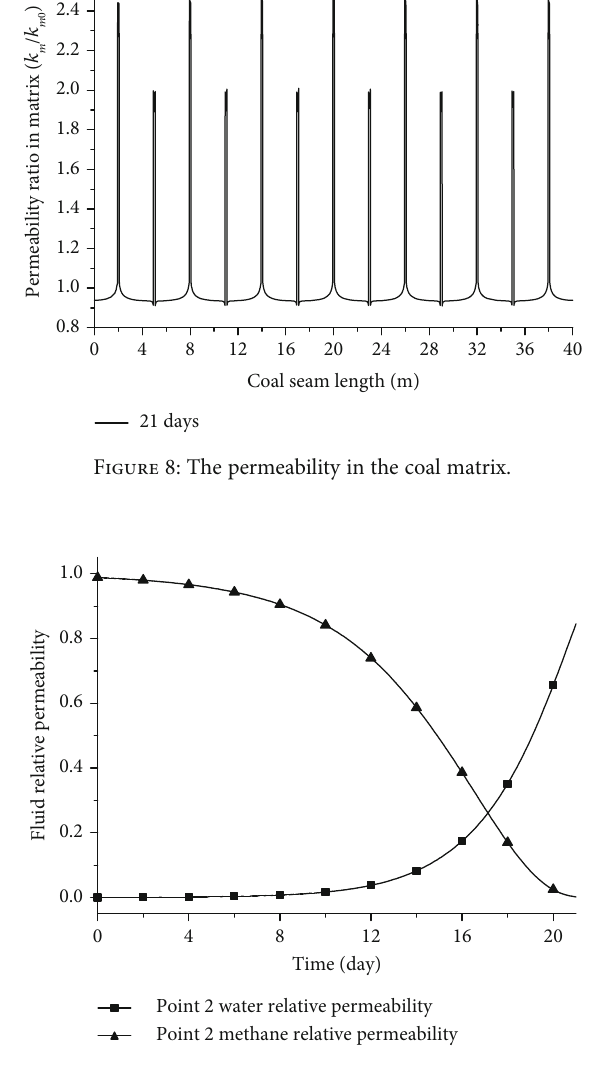
Figure 9: The relative permeability in a coal fracture.